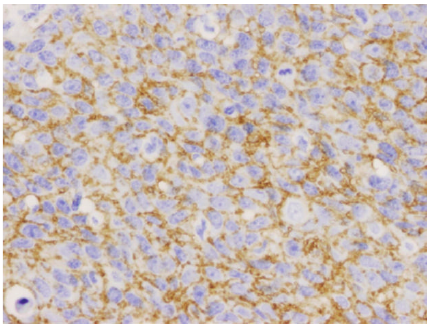
Figure 1: EGFR immunostain with cytoplasmic staining. The brown staining shows where the EGFR is